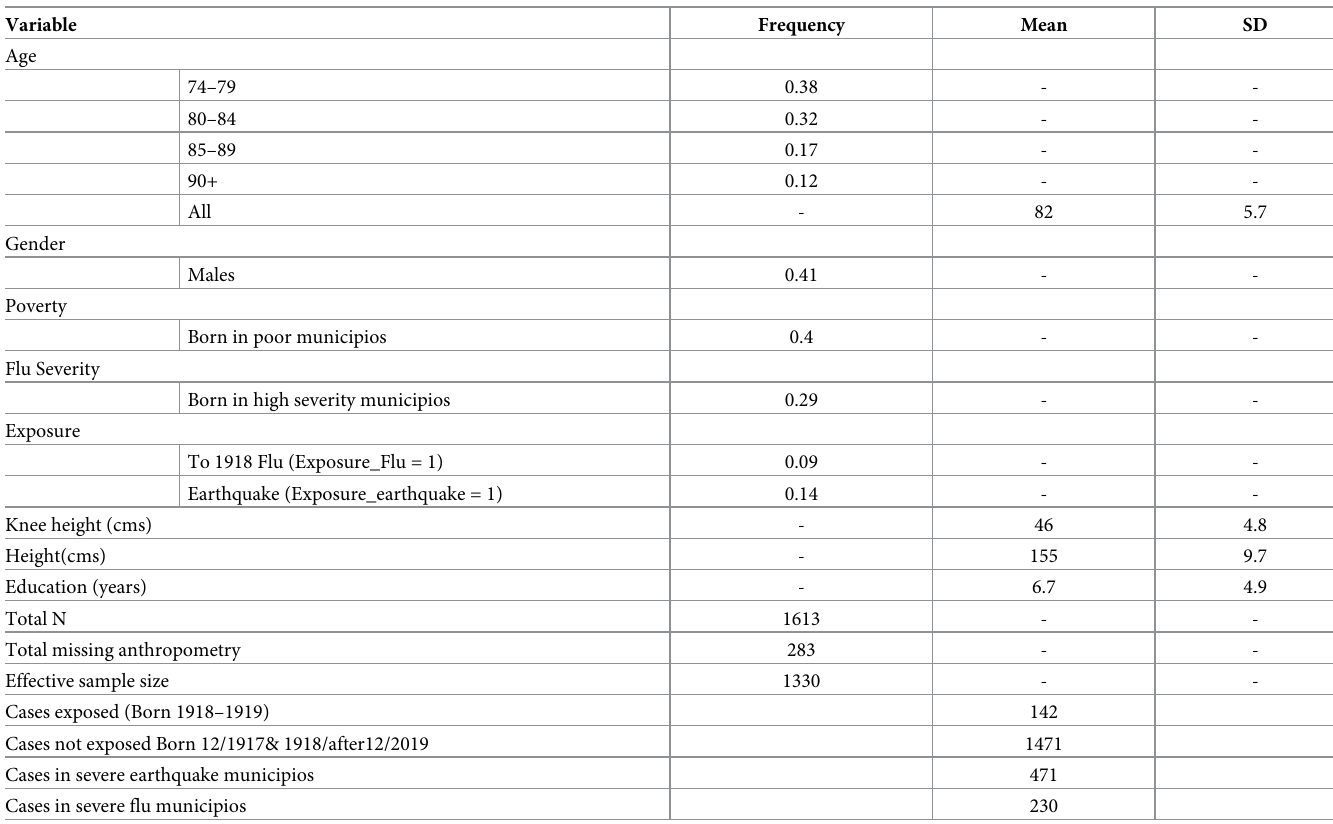
Table 2. Summary of selected sample